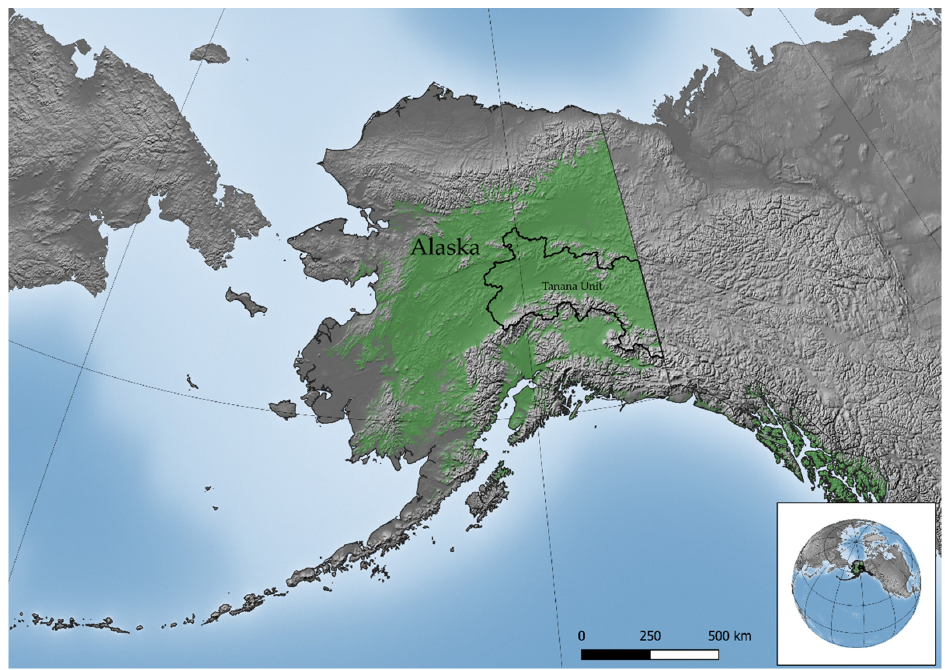
Figure 1. The Tanana Unit study area in Alaska, United States. Approximate extent of forest cover shown in green.